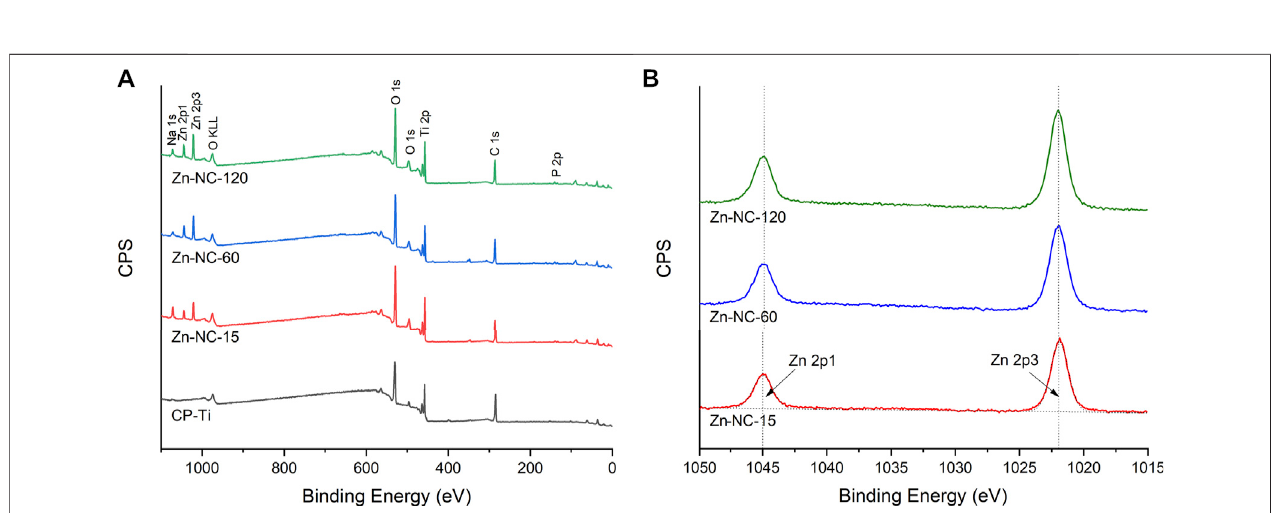
FIGURE2| X-rayphotoelectronspectroscopy analysisofthedifferentsynthesizedsurfaces: (A) Survey spectraofthefoursurfaces; (B) High-resolutionspectraof Zn 2p on the three Zn-NC-Ti surfaces.